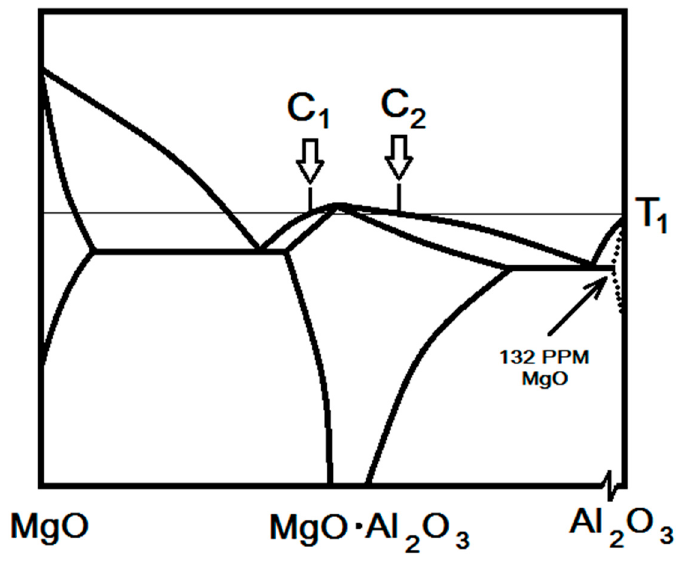
Figure 2. Schematic phase diagram of MgO-Al 2 O 3 . The compositions C 1 and C 2 show the two possible liquid compositions at T 1 as a local temperature at the particle contacts subjected to reactive flash sintering. The Al 2 O 3 -rich side enhanced to reveal the solid solubility limit of MgO in Al 2 O 3 .